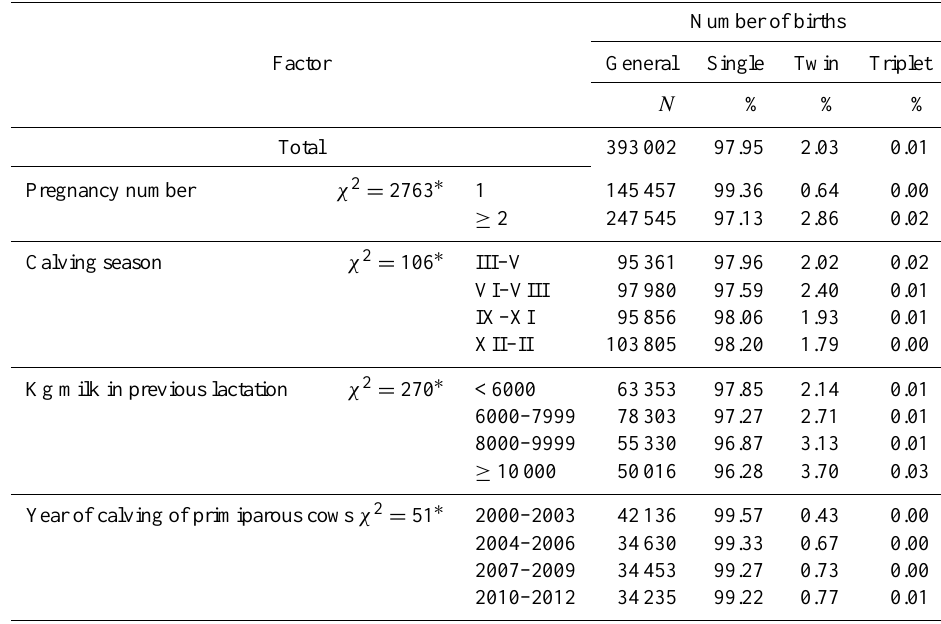
Table 1. Effect of some factors on percentage of single and multiple births in